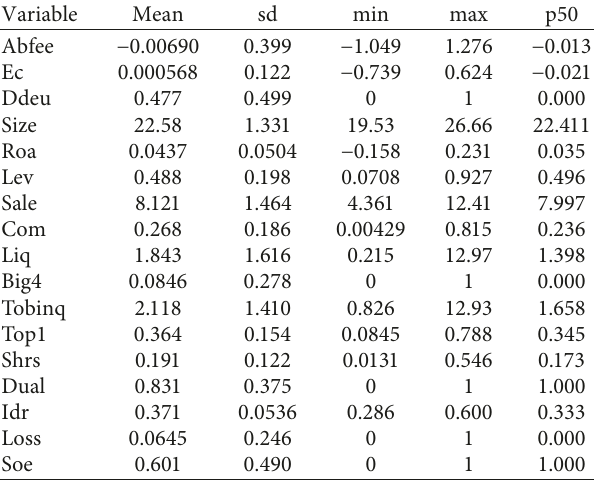
Table 2: Summary